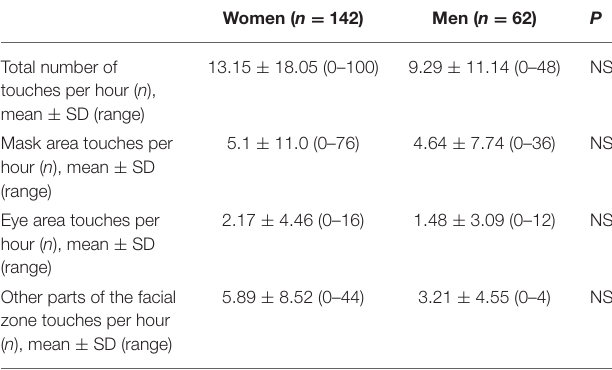
TABLE 1 | The scores and dependencies on selected clinical